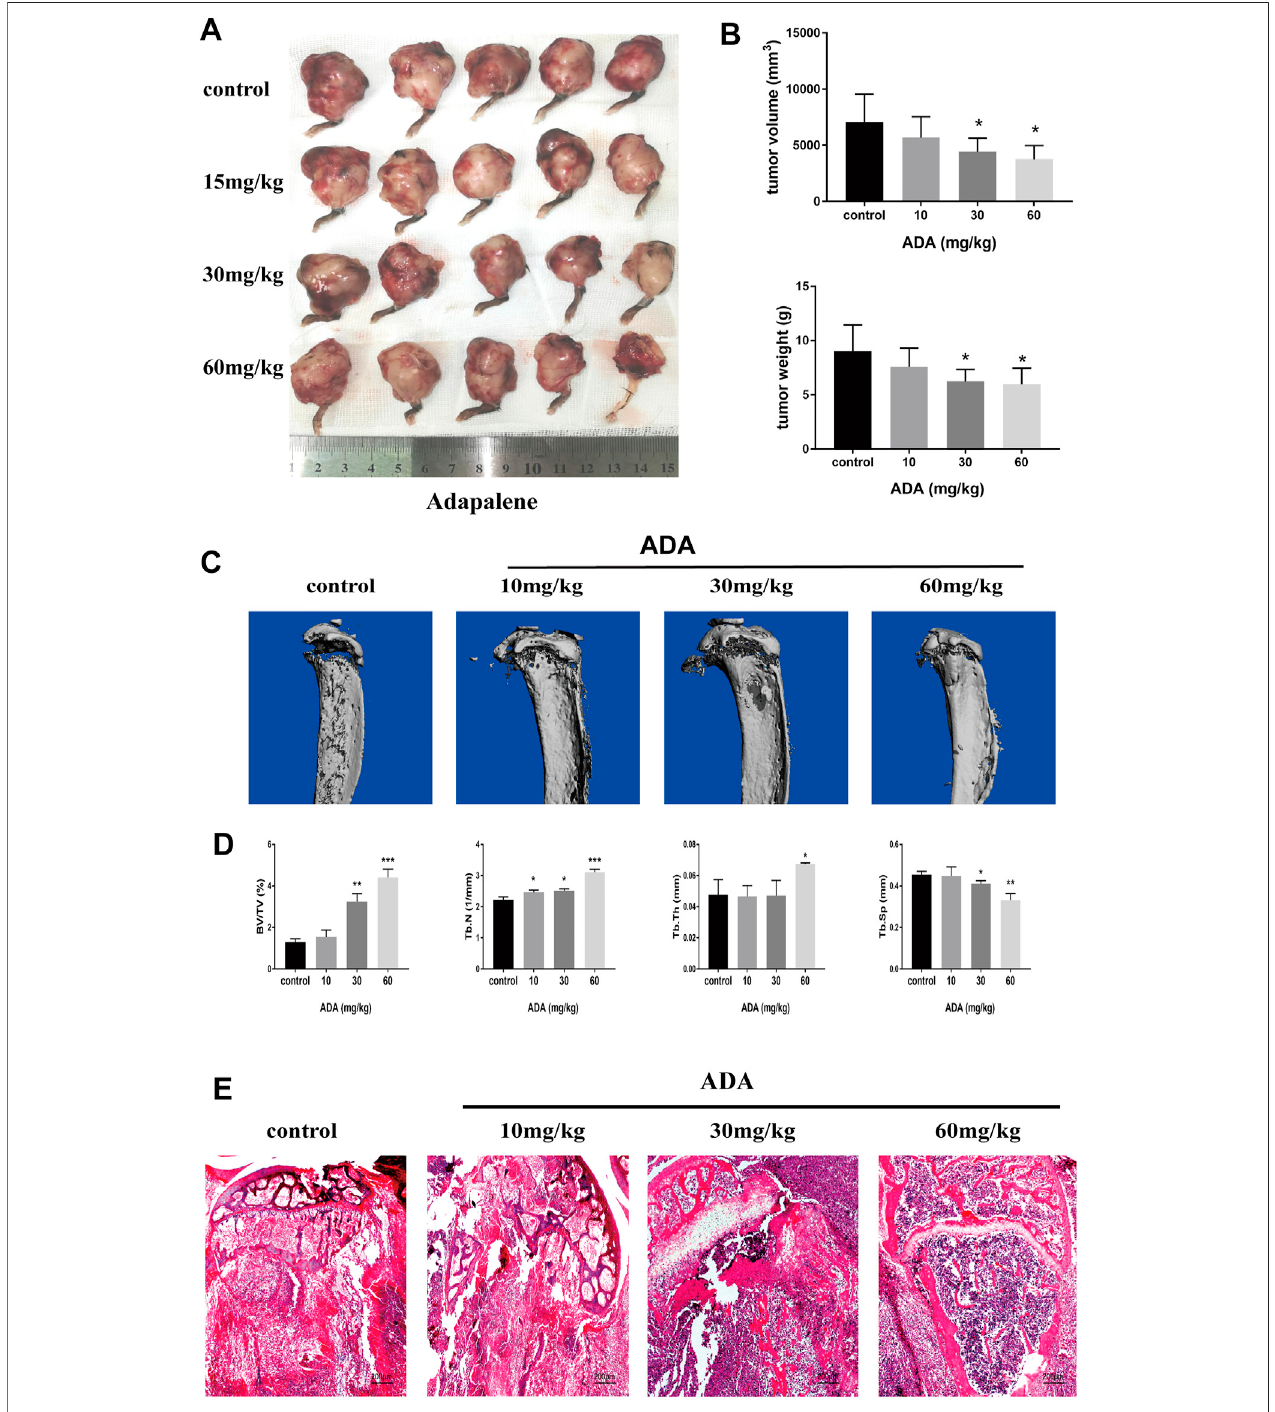
FIGURE 6 | ADA signi fi cantly suppressed tumor growth and osteolytic lesions in mice bone metastased with RM-1 cells. Bone metastasis mice were sacri fi ced after treatment following treatment with increasing doses of ADA (15, 30, and 60 mg/kg) for 14 days. (A) Tumors were measured and photographed at the end of treatment. (B) Analysis of tumor volume and weight. (C) The evaluation of osteolytic lesions and architecture were determined using a micro-CT scanner. (D) Statistical analysis of bone parameters in osteolytic lesions, including trabecular separation (Tb.Sp, mm), connectivity density (1/mm 3 ), trabecular thickness (Tb.Th, mm), trabecular number (Tb.N, 1/mm), and bone volume/tissue volume (BV/TV,%). (E) Bone tumor tissues were detected using Hematoxylin and eosin staining (100×). Data are articulated as mean ± standard deviation. (* p < 0.05; ** p < 0.01; *** p < 0.001 vs. control).